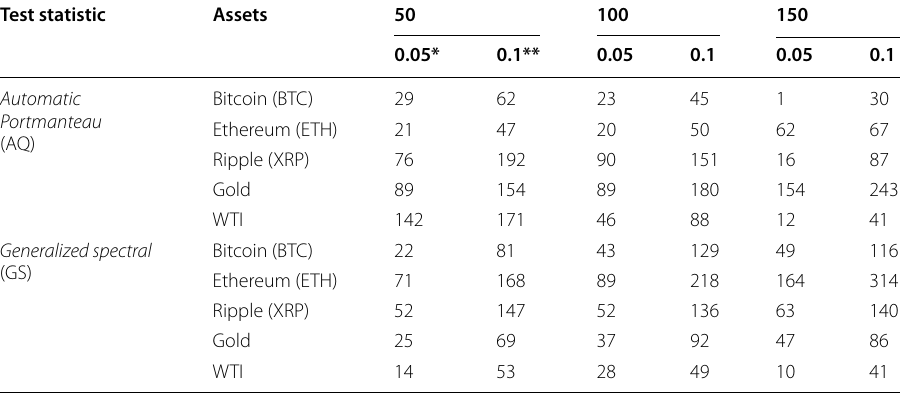
Table 3 The number of observations that reject the null hypothesis for the corresponding test statistic